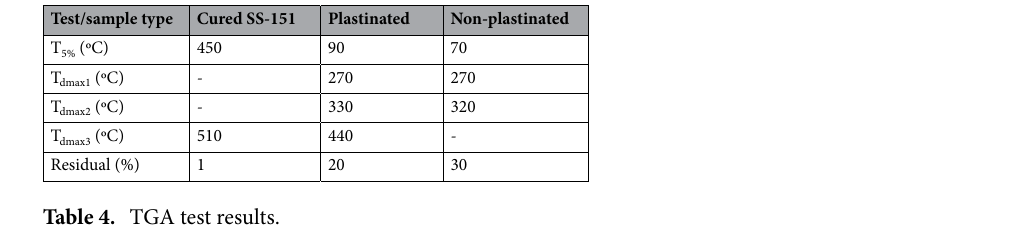
Table 4. TGA test